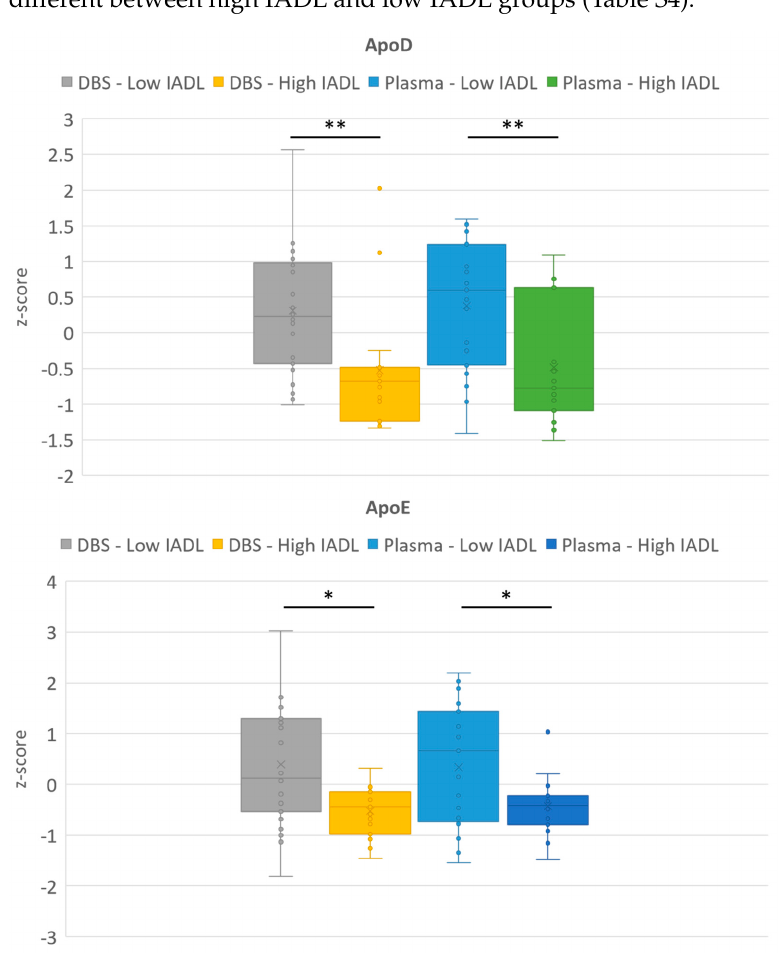
Figure 1. Boxplots of Apolipoprotein D (ApoD) and Apolipoprotein E (ApoE) protein levels as a function of the instrumental activities of daily living (IADL) index. Comparisons were made for both dried blood samples (DBS) and plasma microsamples. The Y-axis corresponds to the z-scores obtained for each of the proteins. Mann–Whitney p -values: * p < 0.05, ** p < 0.01. The circles correspond to individual values and the cross to the mean of the group.